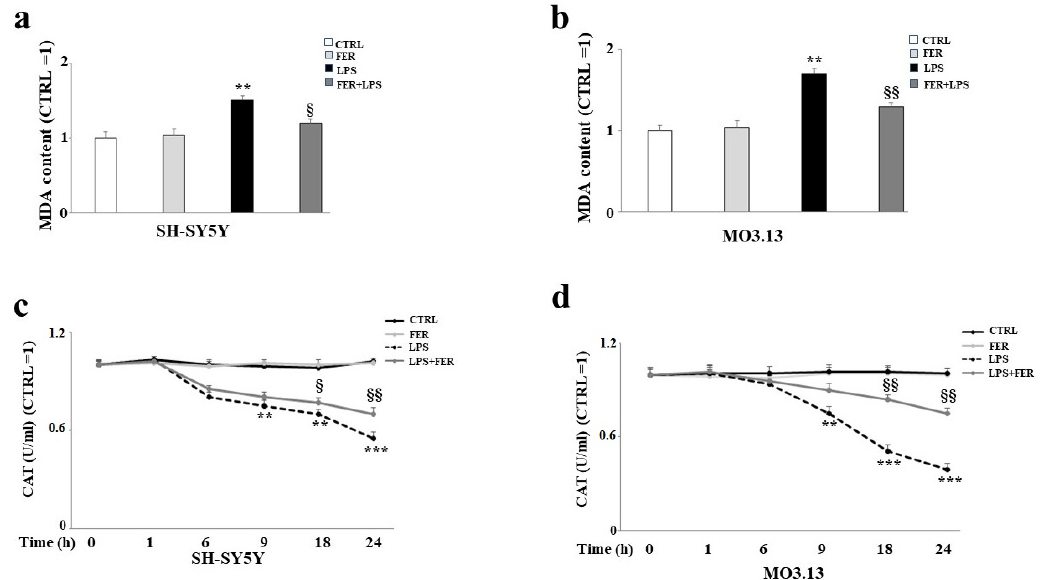
Figure 6. Oxidative profile in SH-SY5Y and MO3.13 cells: evaluation of MDA content and CAT activity. Following treatment with LPS or co-treatment with FER-LPS, the SH-SY5Y and MO3.13 cell lines were subjected to a measurement of their MDA content using a Malondialdehyde assay. The relative quantifications were obtained by fixing a value for an untreated cell as 1 and comparing the values to those of all other samples. The obtained results are shown in Figure 6